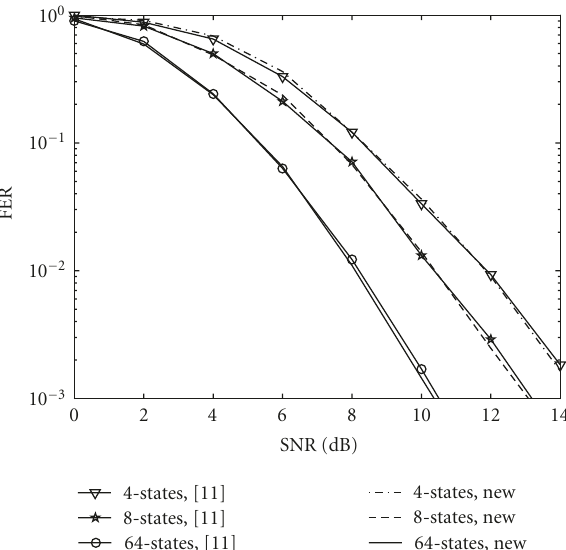
Figure 2: FER versus SNR for the STCCs over Z 3 for 3-PSK based on the trace criterion with n = 3, m = 2,3, and 3,9, and 27 states.